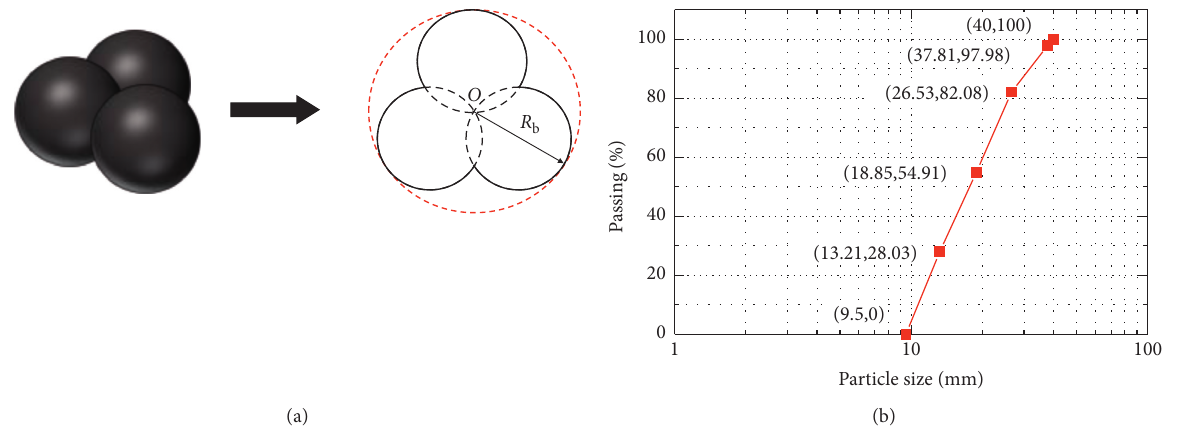
Figure 1: Ballast model and particle size distribution for ballast. (a) Model of ballast. (b) Grading curve for ballast.